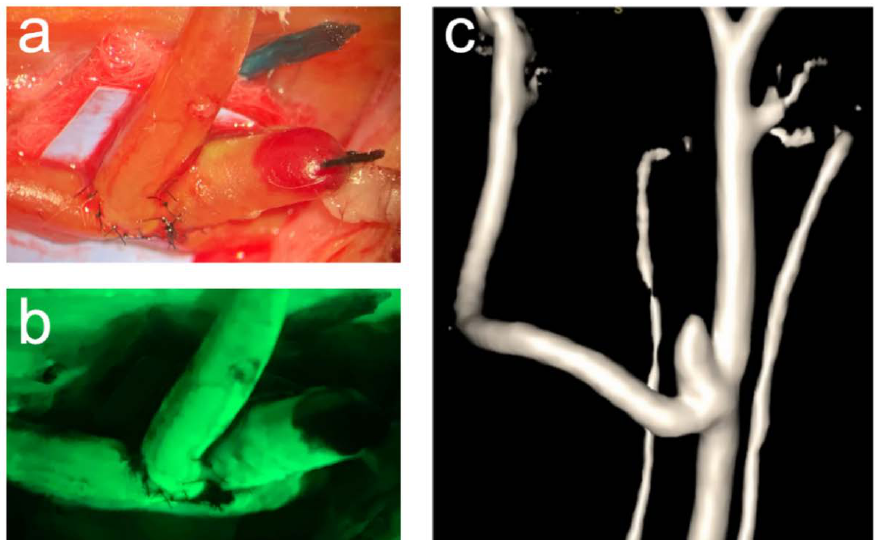
Figure 3. Exemplary illustration of a patent vital bifurcation aneurysm. The operative situs through the operative microscope (a) and the corresponding fluorescence angiography ( b ) visualize blood flow in both, the aneurysm and the parent artery at the time of aneurysm creation. One-month patency is confirmed by magnetic resonance angiography ( c ).